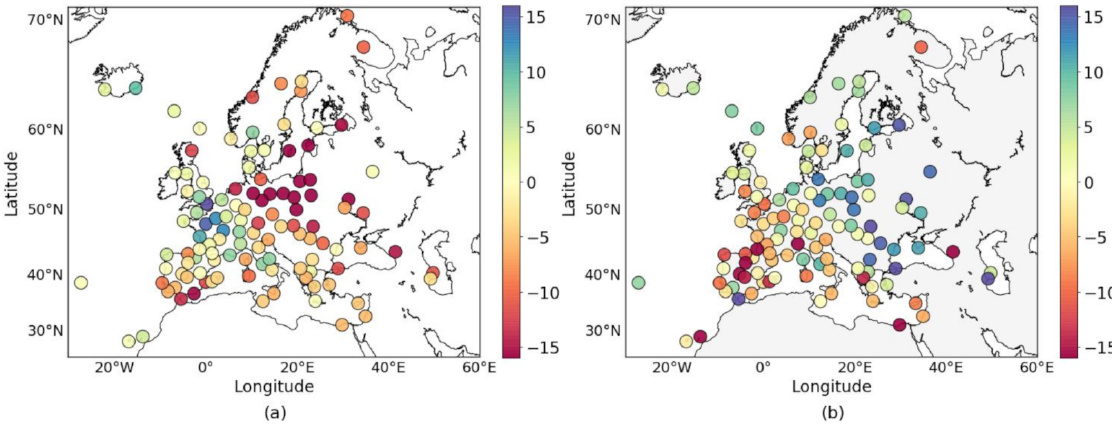
Figure 14. Spatial pattern coefficients describing the second SVD of the residuals of the TWS and those of the Up coordinate. ( a ) TWS spatial pattern; ( b ) Up spatial